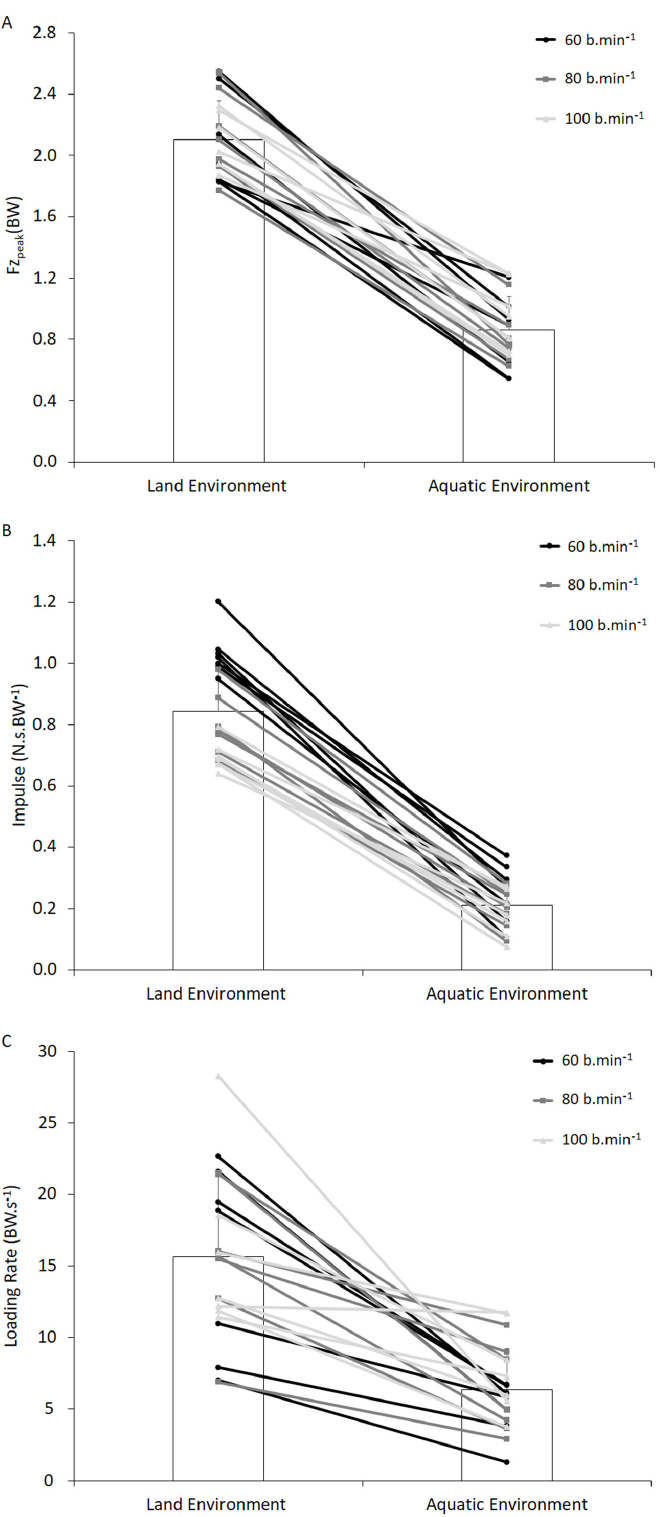
Figure 1. Mean (bars) and individual (lines) vertical ground reaction force ( A ), impulse ( B ) e loading rate ( C ) values in the aquatic and land environments during the performance of the stationary running exercise in three different cadences (60, 80 and 100 b min − 1 ). Note: Bars correspond only to the “environment” main effect representing the mean value for all cadences investigated in each